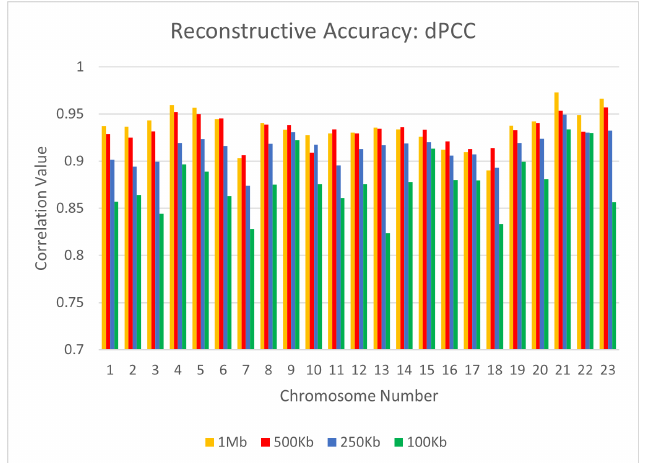
Figure 6. Comparison of distance Pearson Correlation Coefficient (dPCC) for CBCR on all 23 chromosomes at four different resolutions: 1 mb, 500 kb, 250 kb, and 100 kb.